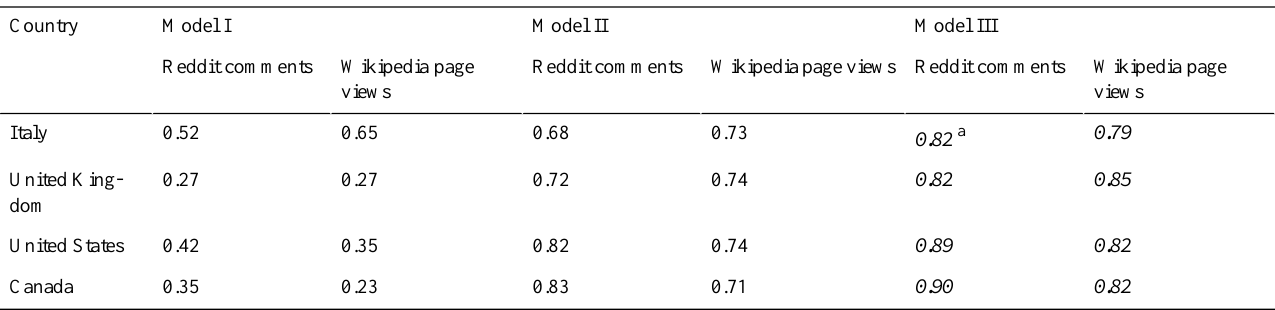
Table 2. Adjusted R 2 values for the three linear regression models applied to predict Reddit comments and Wikipedia page views ( P